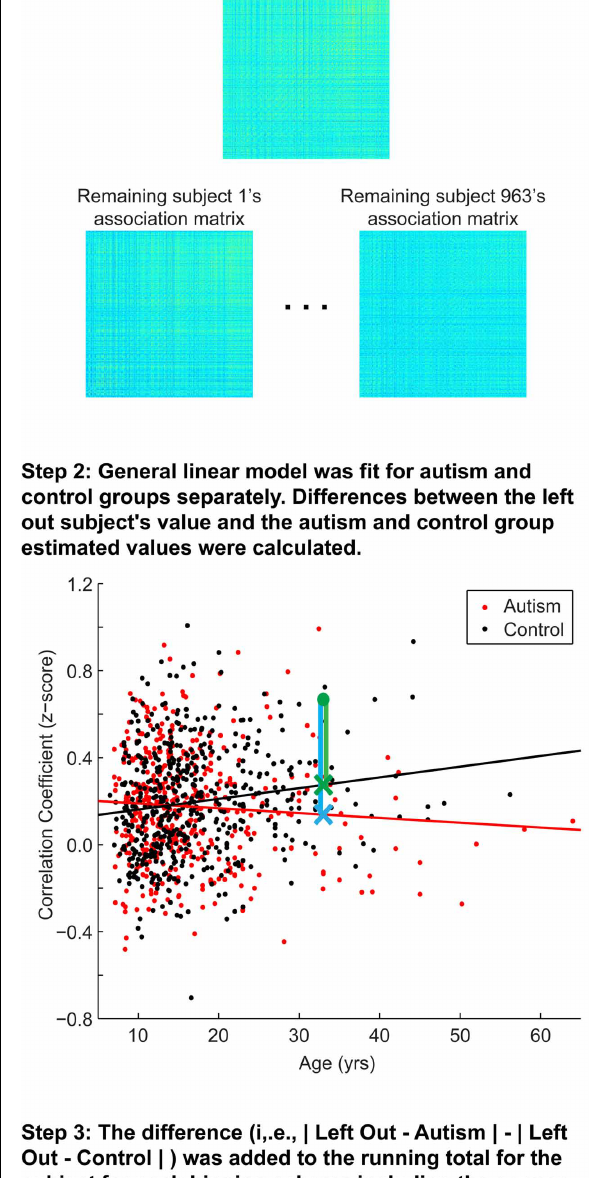
FIGURE 1 | Summary of classification approach. Step 1, Association matrices corresponding to the intrinsic connectivity between each pair of 7266 gray matter regions (about 26.4 million connections) are estimated